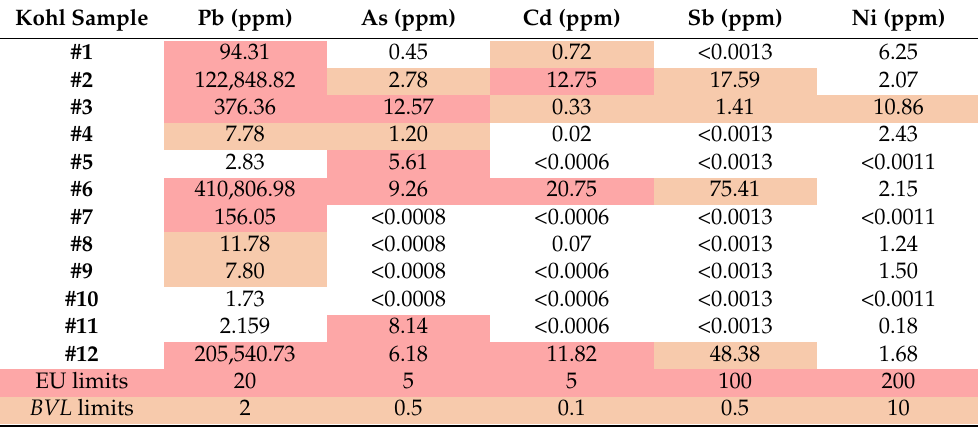
Table 4. Levels of heavy metals ( ppm or µ g/g) in kohl samples compared to the limitations established by governmental institutions. Orange boxes indicate values above the German Federal Office of Consumer Protection and Food Safety ( BVL ) [45,46] limits. Red boxes show levels which exceed the EU (EU) legal limits